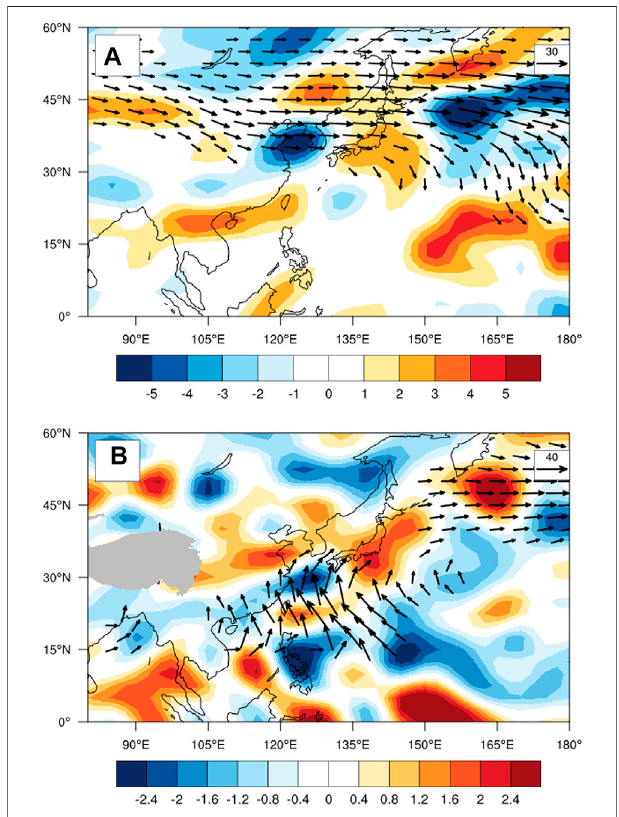
FIGURE 7 | Summer mean relative vorticity (shadings, unit : 10 − 6 s − 1 ) and associated wave activity fl ux (vectors, unit : m 2 s − 2 ) at (A) 200 and (B) 850 hPa composited in positive years in P1 (only values signi fi cant at/above the 95% con fi dence level by Student ’ s t test are shown).